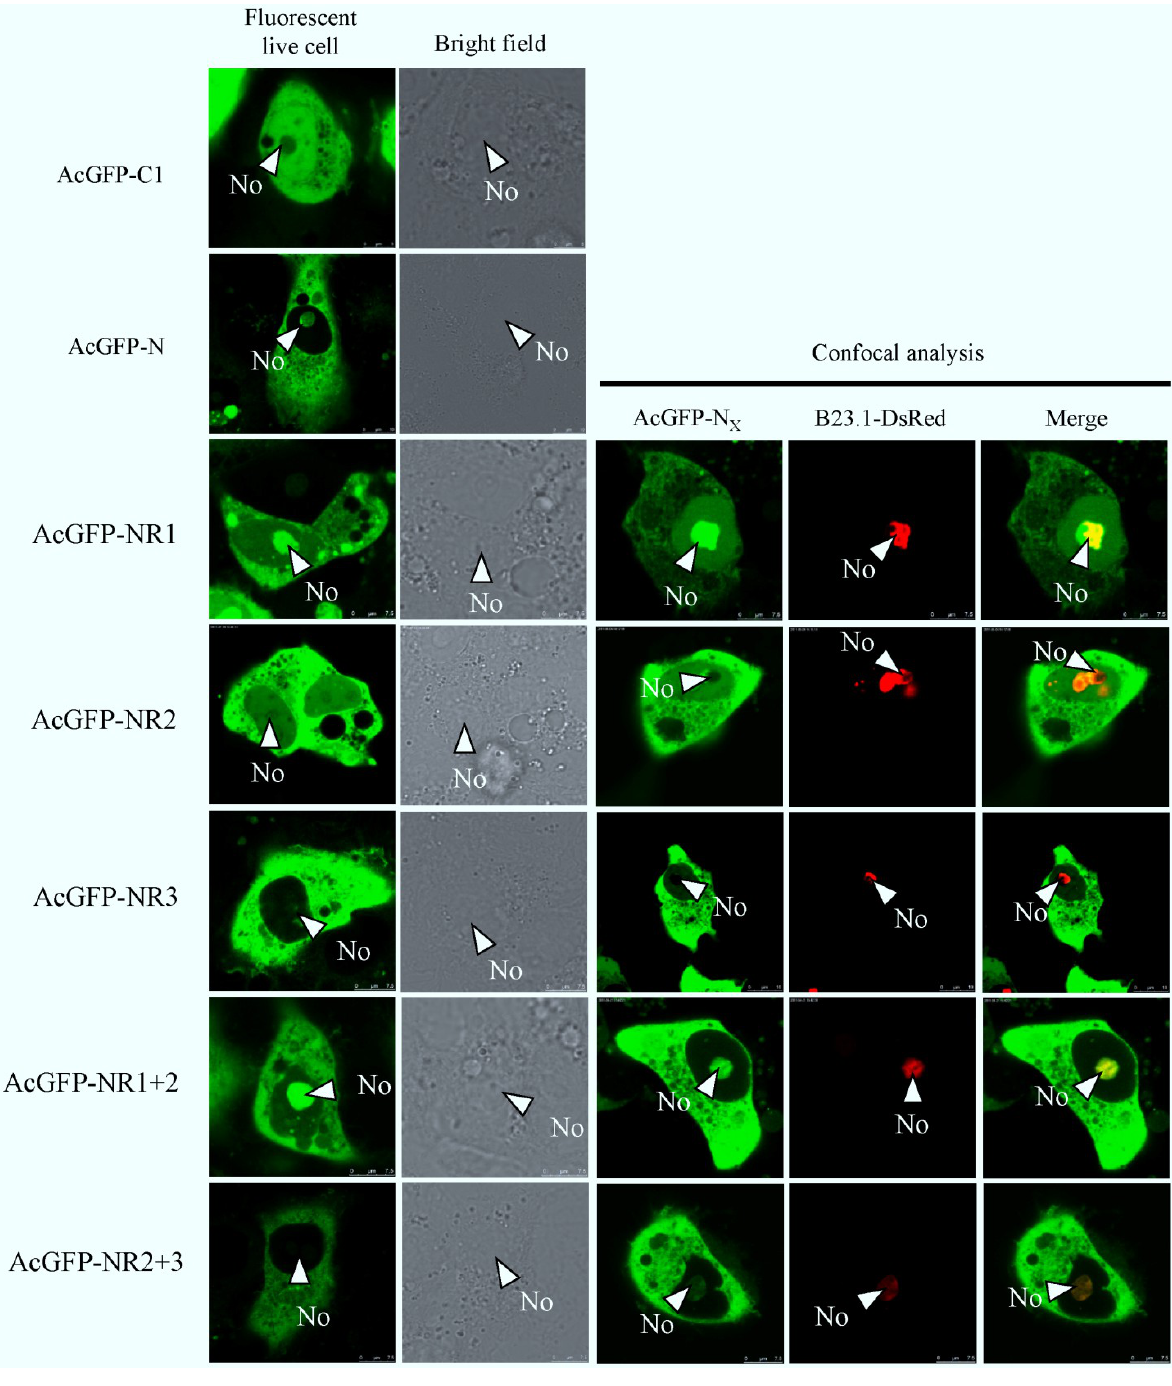
Figure 3. Live cell and confocal microscopy of the subcellular localization of fluorescent fusion proteins: AcGFP, AcGFP-N, AcGFP-NR1, AcGFP-NR2, AcGFP-NR3, AcGFP-NR1+2, and AcGFP-NR2+3 proteins. Vero cells were visualized 24 h post-transfection in culture conditions. Confocal analysis of the subcellular localization of AcGFP, AcGFP-N, AcGFP-NR1, AcGFP-NR2, AcGFP-NR3, AcGFP-NR1+2, and AcGFP-NR2+3 proteins in cells co-expressing B23.1-DsRed, at 24 h post-transfection. The PEDV fusion peptides are colored green and the B23.1 fusion protein colored red. Merged images are also presented. The nucleolus (No) is arrowed where